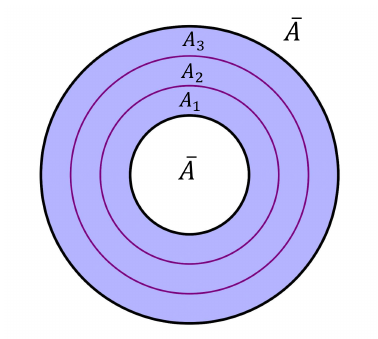
∪ A ∪ A to be an annulus whose inner 1 2 3 and R . It is divided into three smaller annulues by the two 1 2